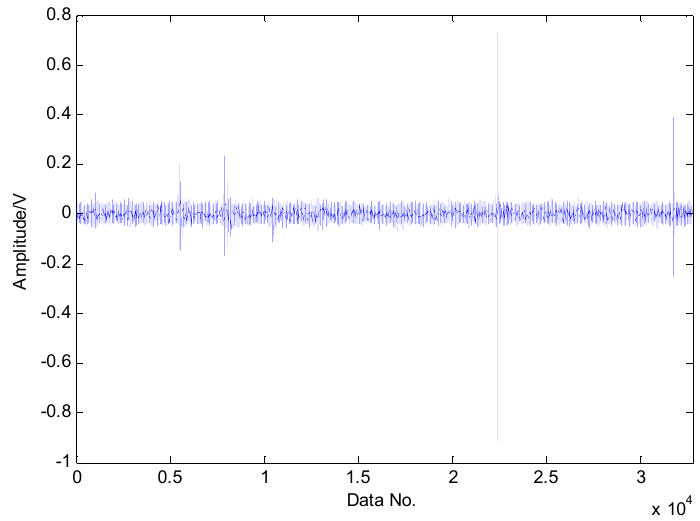
Figure 18. Original vibration signals collected from roller bearing with a rolling-element fault.